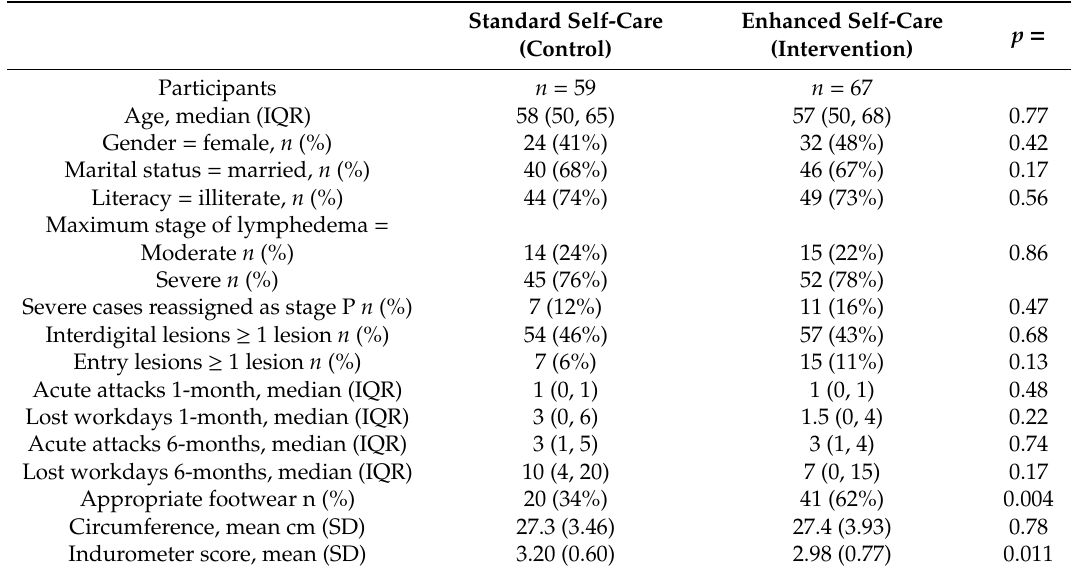
Table 1. Participant characteristics at